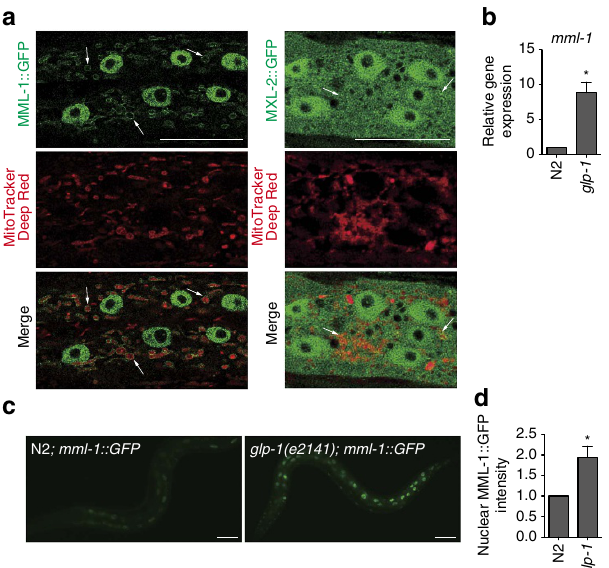
Figure 2 | MML-1 is regulated on germline removal. ( a ) MML-1::GFP and MXL-2::GFP (green) in hypodermal cells (wild type, L4 stage). MML-1::GFP is localized to the nucleus and the mitochondria (white arrows). MXL- 2::GFP is not specifically localized, but occasionally overlapped with the mitochondria (white arrows). Mitochondria are marked by MitoTracker Deep Red (Red). ( b ) mml-1 transcripts are upregulated in glp-1(e2141) animals relative to wild-type N2 as measured by qRT–PCR using total RNA samples prepared from 4 200 young adult worms. Mean ± s.e.m. from three independent experiments are depicted and are normalized to wild- type N2. P -value (* P o 0.05) was determined by t -test. ( c ) The representative fluorescent images of mml-1 ::GFP transgenic worms in wild- type N2 and glp-1 worms at day 1 young adult stage. Nuclear MML-1::GFP is elevated in glp-1 animals. ( d ) Quantification of nuclear MML-1::GFP in the posterior intestinal nucleus at day 1 young adult stage. Mean ± s.e.m. from four biological replicates ( 4 20 worms each) relative to N2 are presented. P -value (* P o 0.05) was determined by t -test. Two other independent MML- 1::GFP transgenic lines show a similar tendency (not shown). Scale bars, 20 m m ( a ) and 50 m m ( c